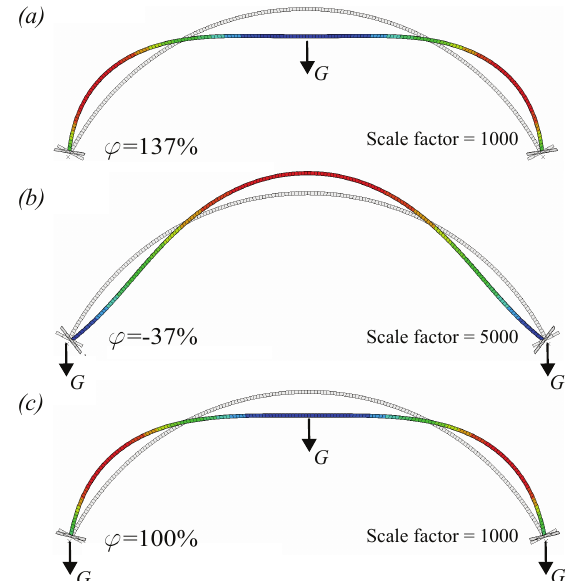
Figure 11. Influence of gravity load on the rotations of the simplified curved shell structure; ( a ) gravity load is imposed only on the shell structure only, causing outward rotation of the supports; ( b ) gravity load is imposed only on the supports, resulting in an opposite direction rotation; ( c ) gravity is imposed on the entire model, resulting in the final outward rotation; the rotations and displacements of the structure are scaled for